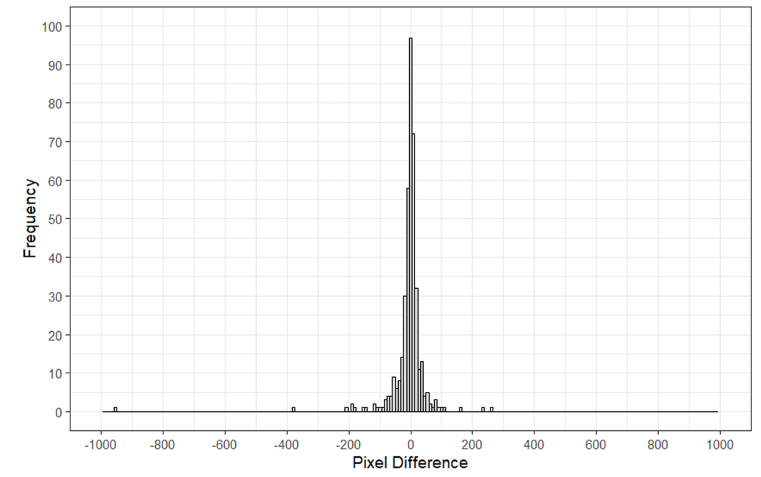
Figure 13. Distribution of pixel deficit and excess.